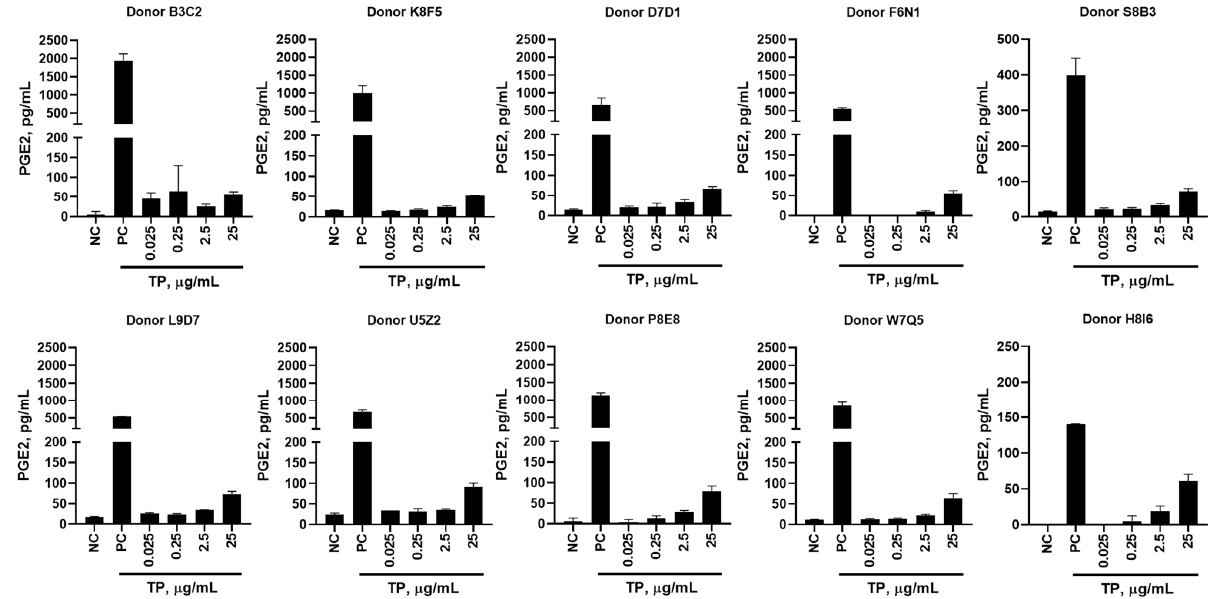
Figure 6. Seven-plex Induction of Prostaglandin-E 2 by Teriparatide. PBMCs from 10 healthy human donors were treated with 0.025, 0.25, 2.5, and 25 μ g/mL teriparatide (TP), compared to a PBS negative control (NC) and LPS/PHA-M/ODN positive control (PC), for 24 h. Supernatants were analyzed for the presence of PGE-2 by 7-plex multiplex ELISA. Each bar shows mean and standard deviation (N = 2).